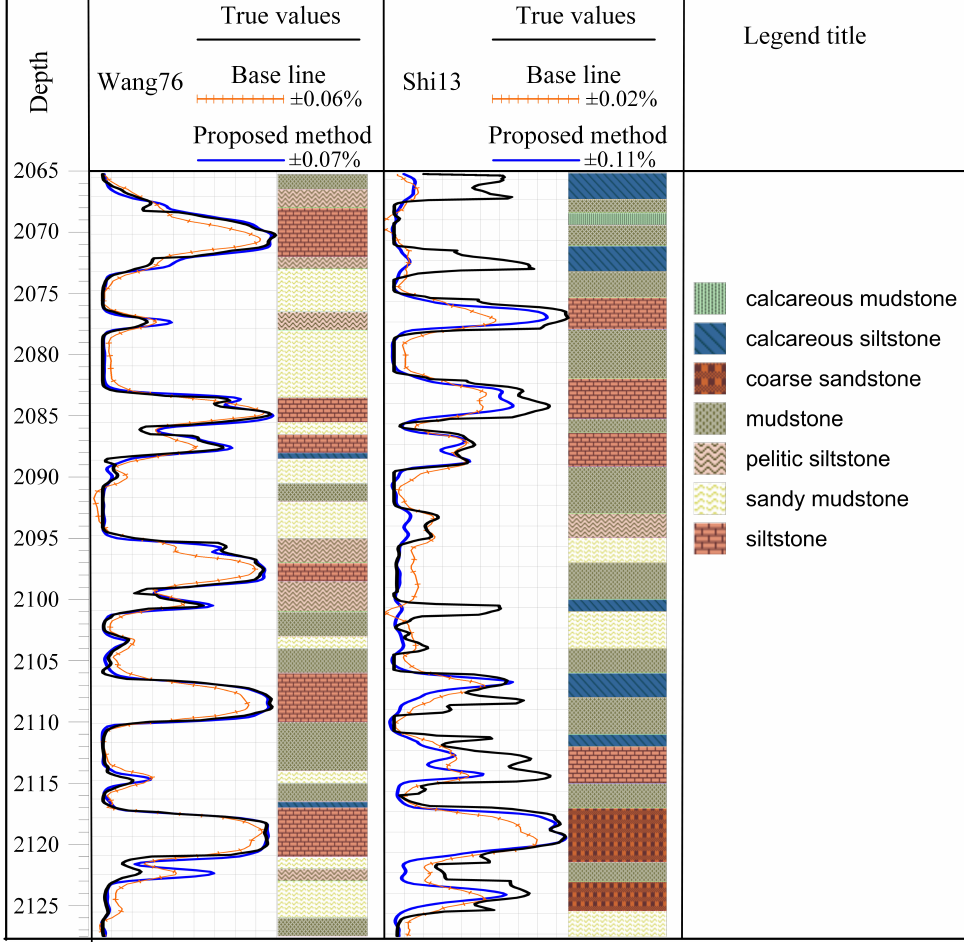
Figure 25. Partial prediction results of porosity for well Wang76 and